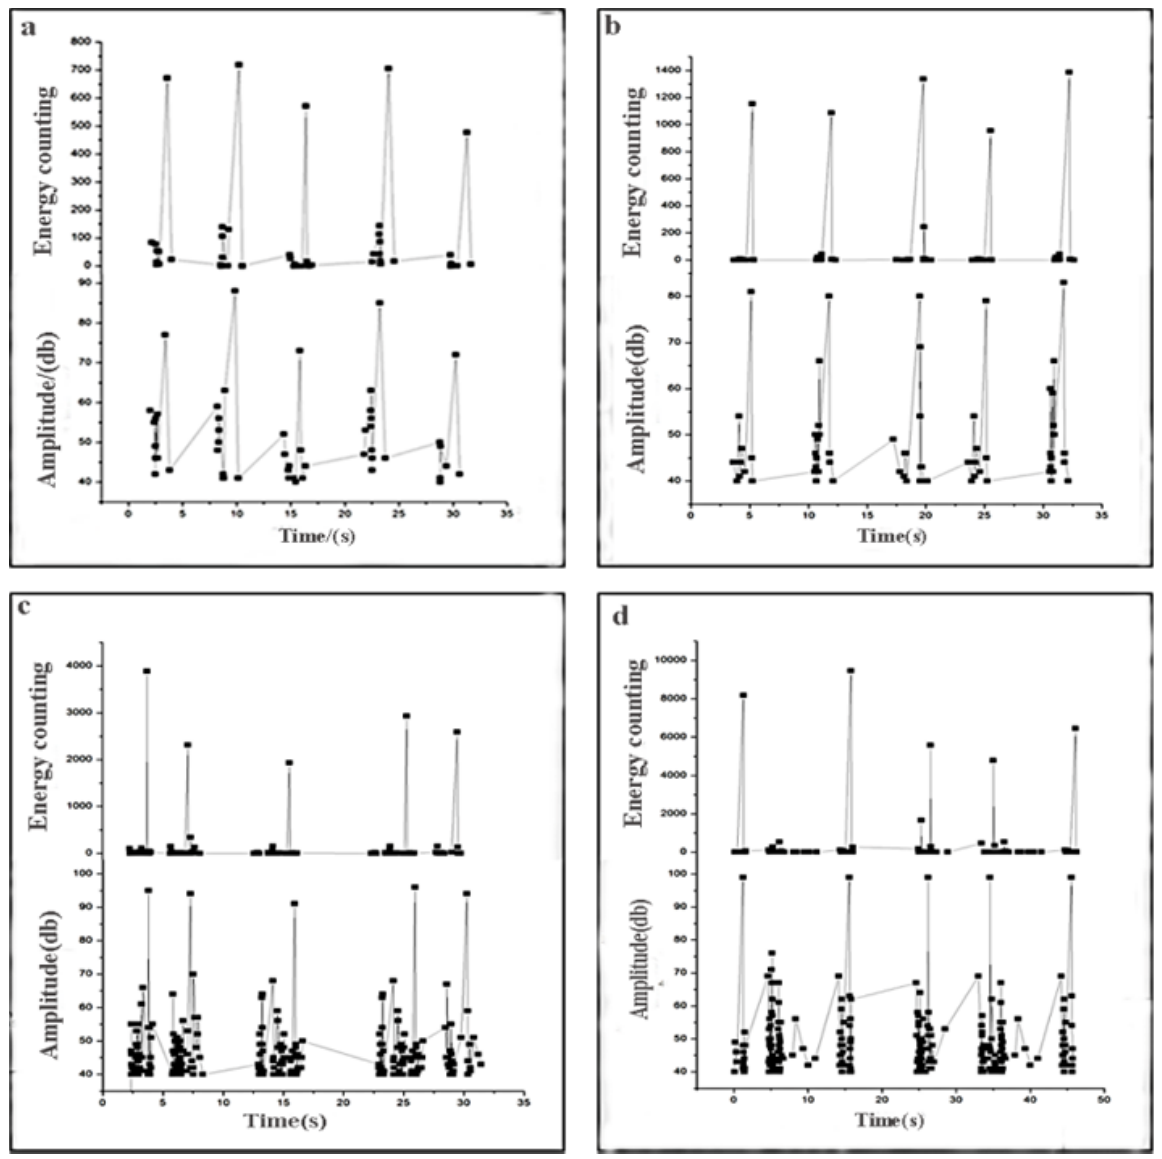
Figure 8: Acoustic emission(AE) signals analysis of coating: (a)Substrate; (b)NiCr coating; (c)Al 2 O 3 coating with the undercoating of NiCr; (d)Al 2 O 3 coatingtion SEM